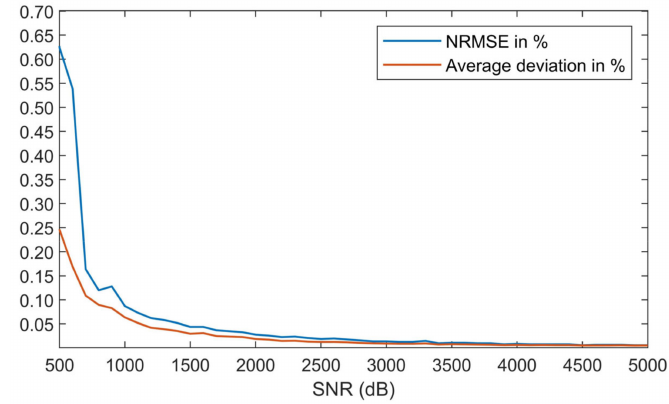
Figure 10. Deviations of the cross-correlation spectrum using different signal lengths N